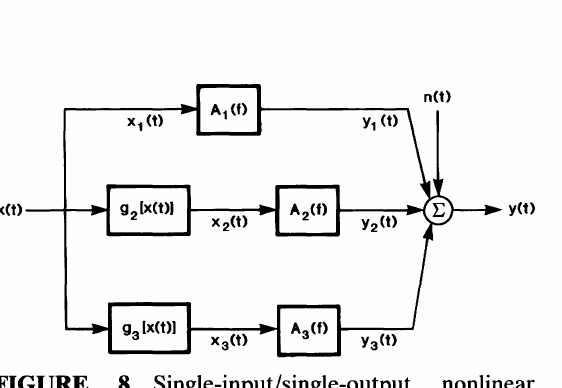
FIGURE 8 Single-input/single-output nonlinear model of a linear system in parallel with two nonlinear systems.